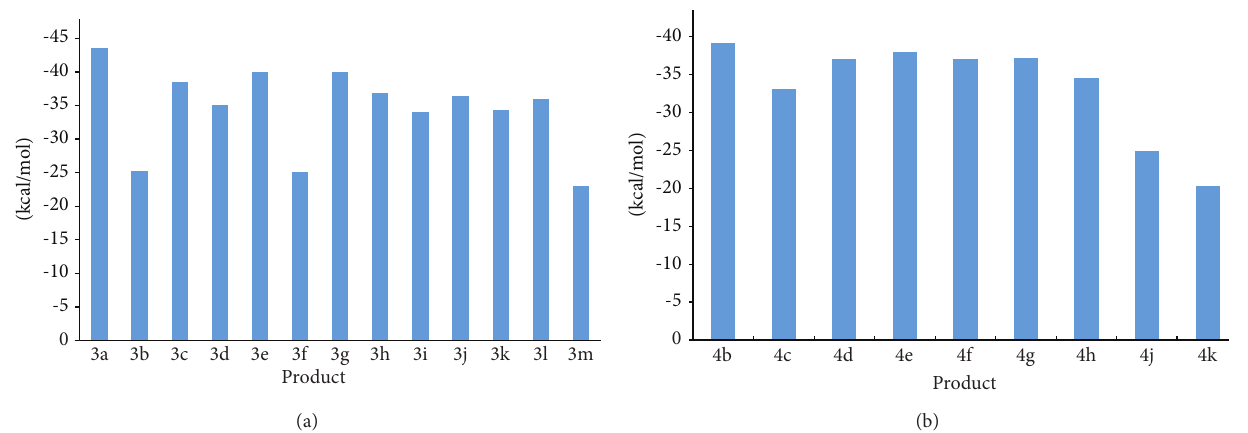
Figure 2: Reaction energy between 1a–1m with 2a–2k in the presence of PhI(OAc)